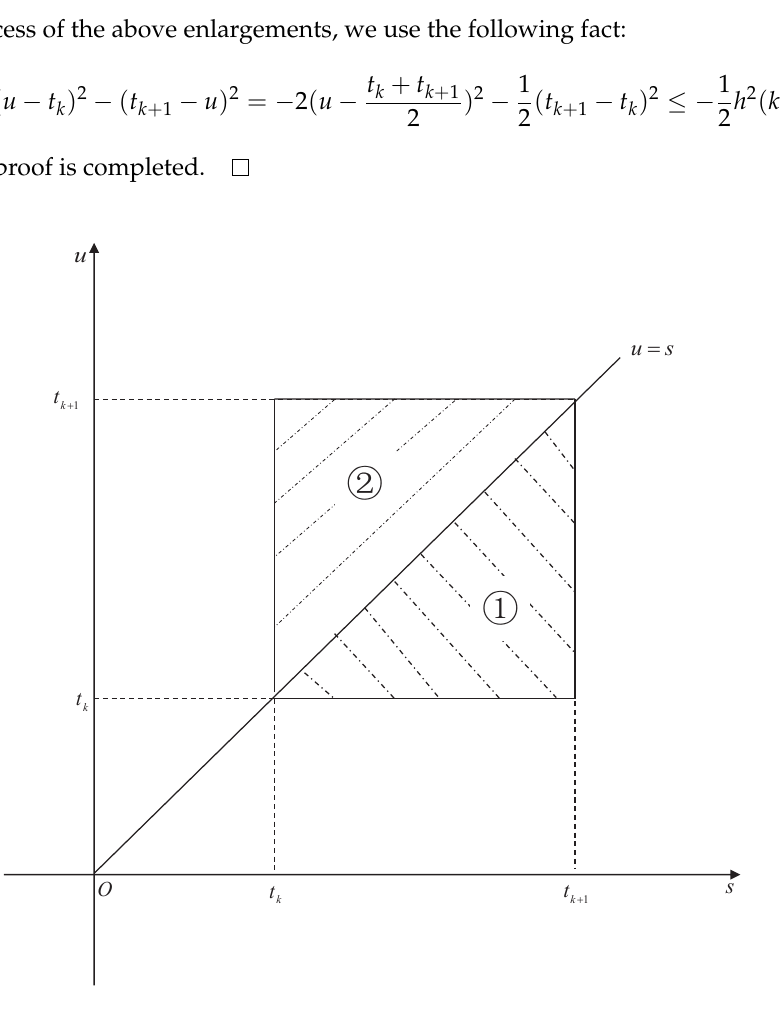
Figure 1. The integral